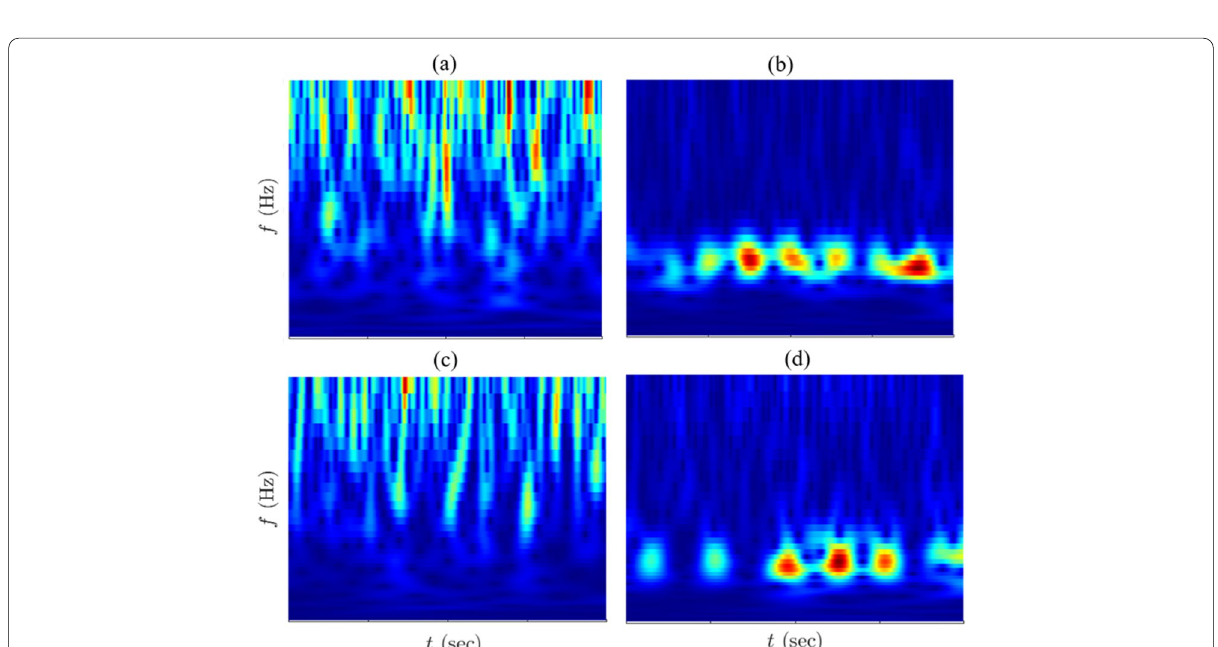
Fig. 19 Spectrograms of IMFs using ( a ) undamaged, ( b ) damaged AE data obtained from sensor A 1 , and ( c ) undamaged, and ( d ) damaged AE data from sensor A 2 for damage at